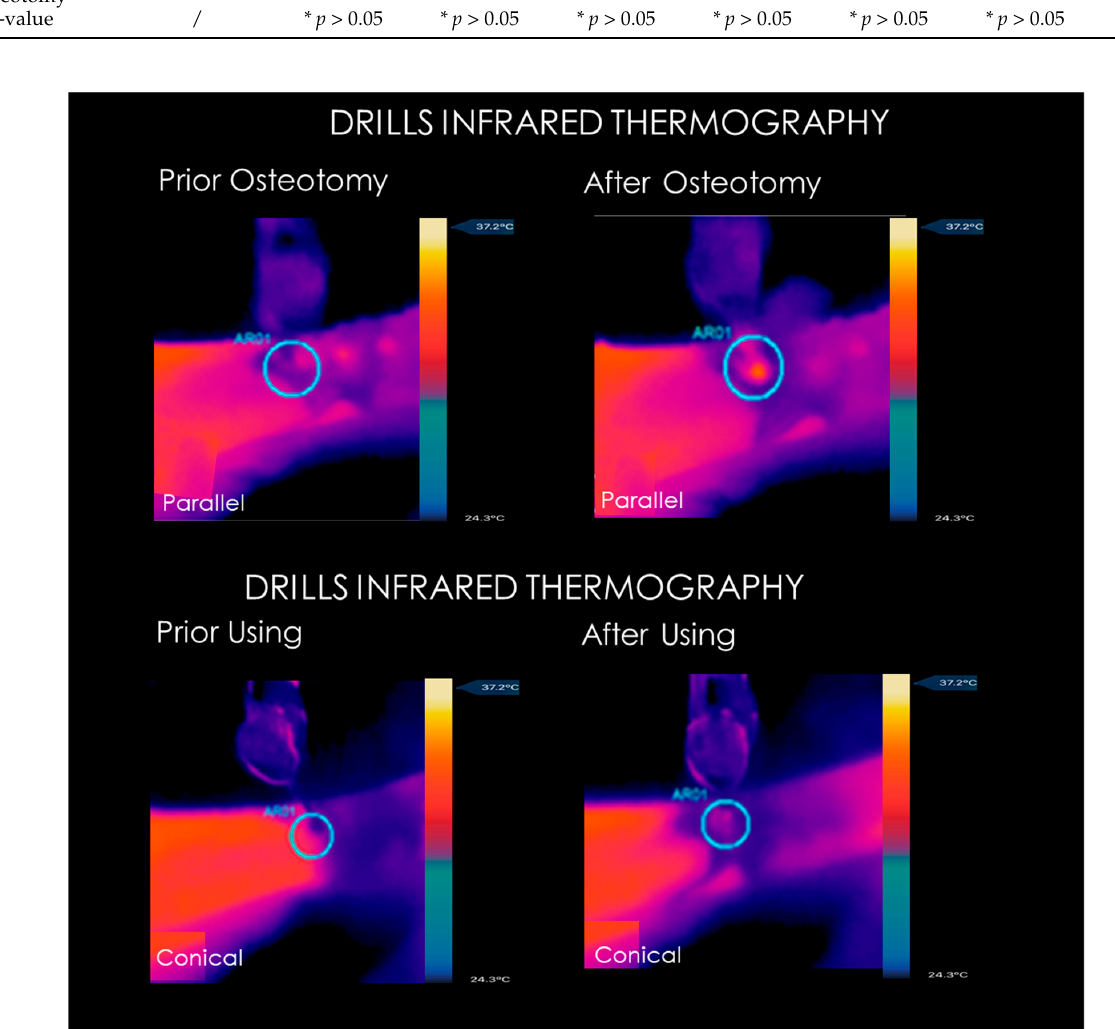
Figure 7. Details of the infrared thermal measurements. Table 1. Summary of the statistical analysis of the drills’ temperatures [Mann–Whitney Test; * p < 0.05] .